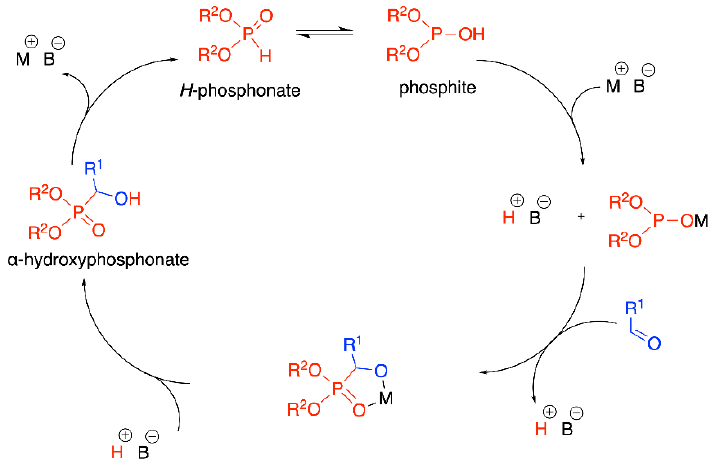
Scheme 1. Generally accepted mechanism for the Pudovik